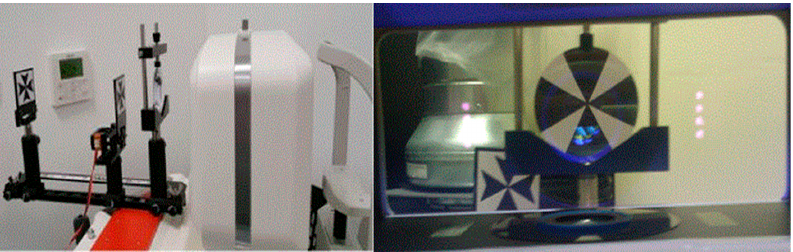
Figure 2. The set-up of the auto-refractor and Badal lens system ( left ), and the subject’s view of the Maltese targets whilst measuring accommodative dynamics ( right ).